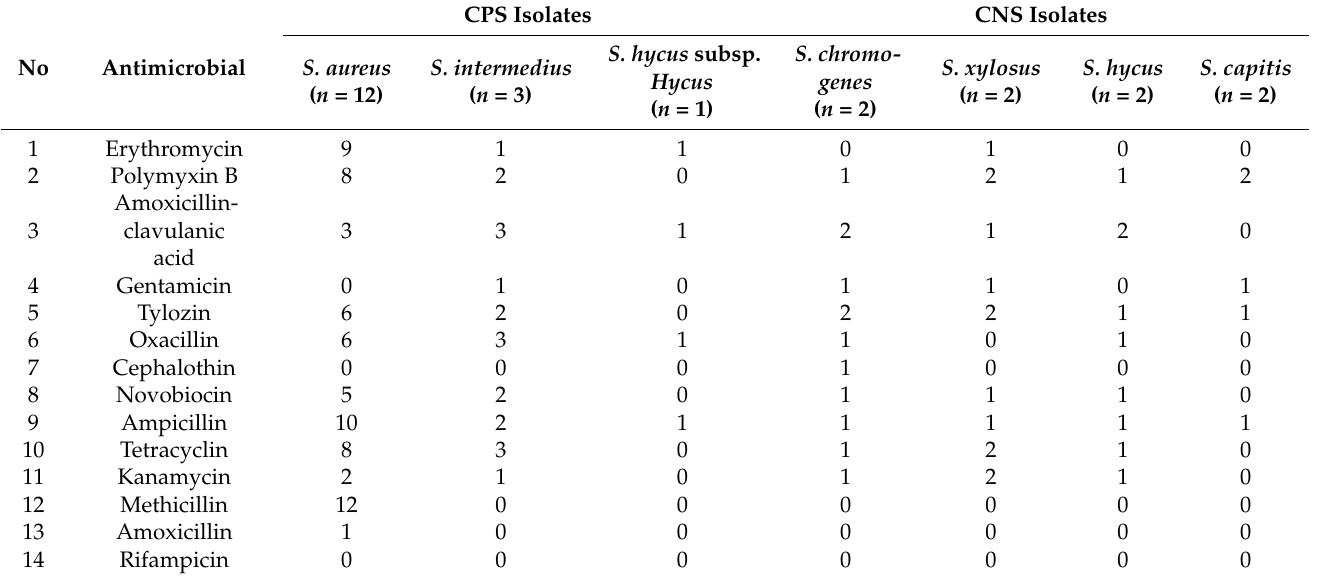
Table 2. Antimicrobial drug resistance profile of the isolated staphylococci